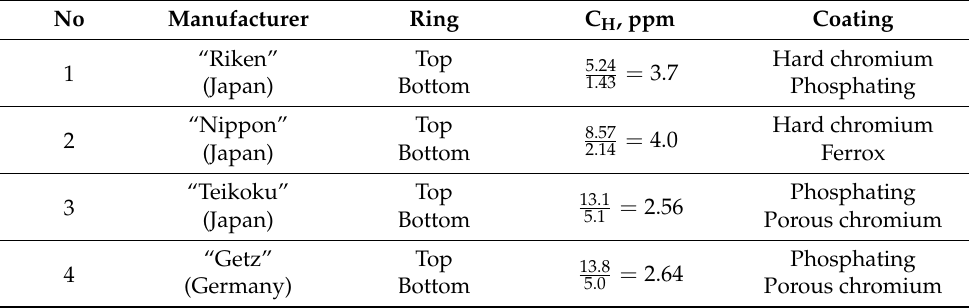
Table 4. The hydrogen concentration in piston rings depending on their